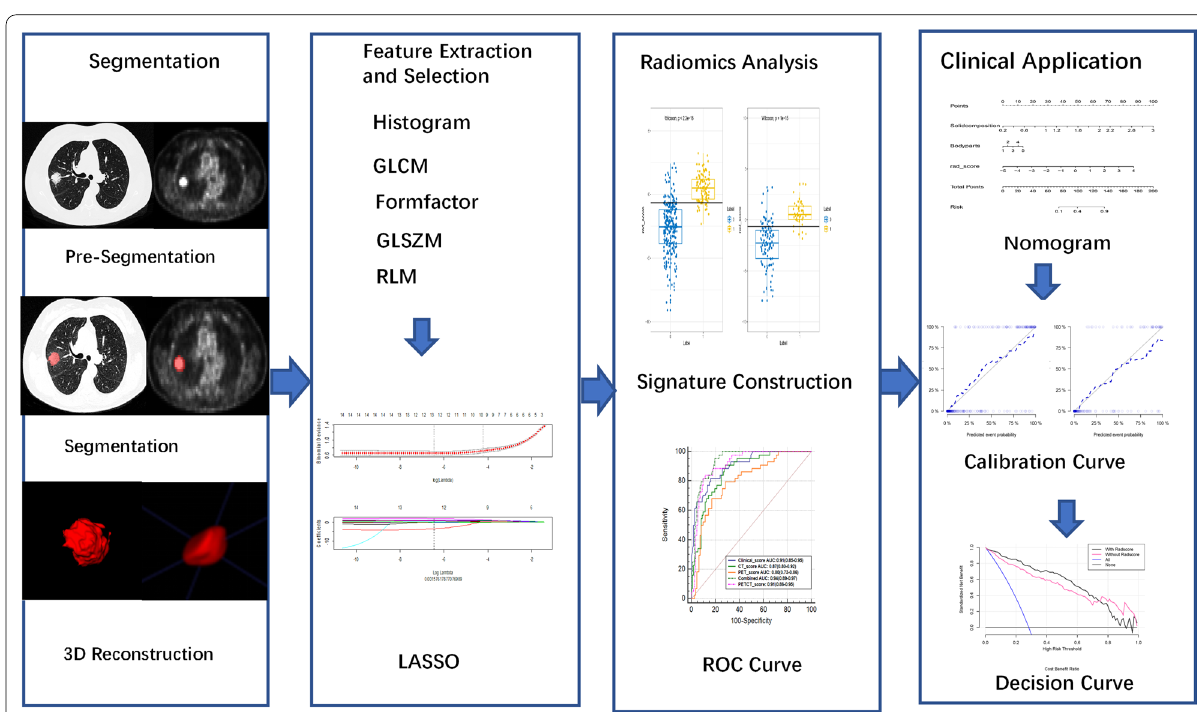
Fig. 1 Workflow for developing a radiomics model based on PET/CT images to predict the thoracic LNM of lung adenocarcinoma. GLCM, gray level co-occurrence matrix; GLSZM, grey level size zone matrix; RLM, run length matrix; mRMR, maximum relevance minimum redundancy; LASSO, least absolute shrinkage and selection operator; ROC, receiver operating